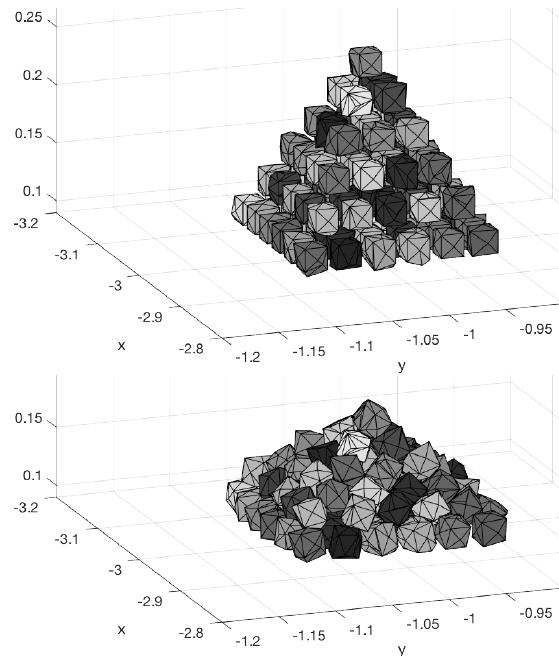
Figure 6. Initialization configuration (above) of the heap and final configuration reached after 0.14 [s] with dimensions in